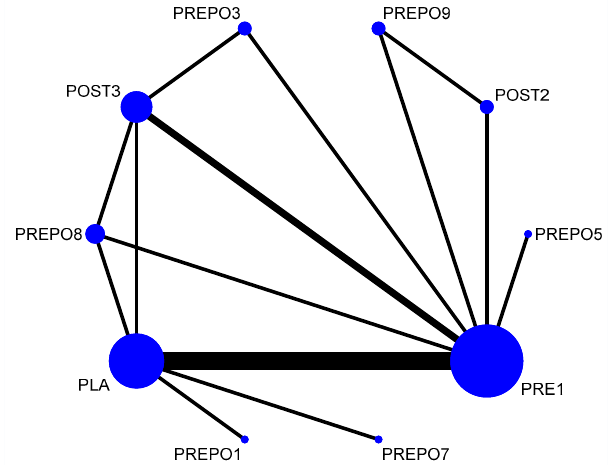
Figure 5. Network plot: implant failure (per implant). Abbreviations: PLA = placebo/no antibiotics;